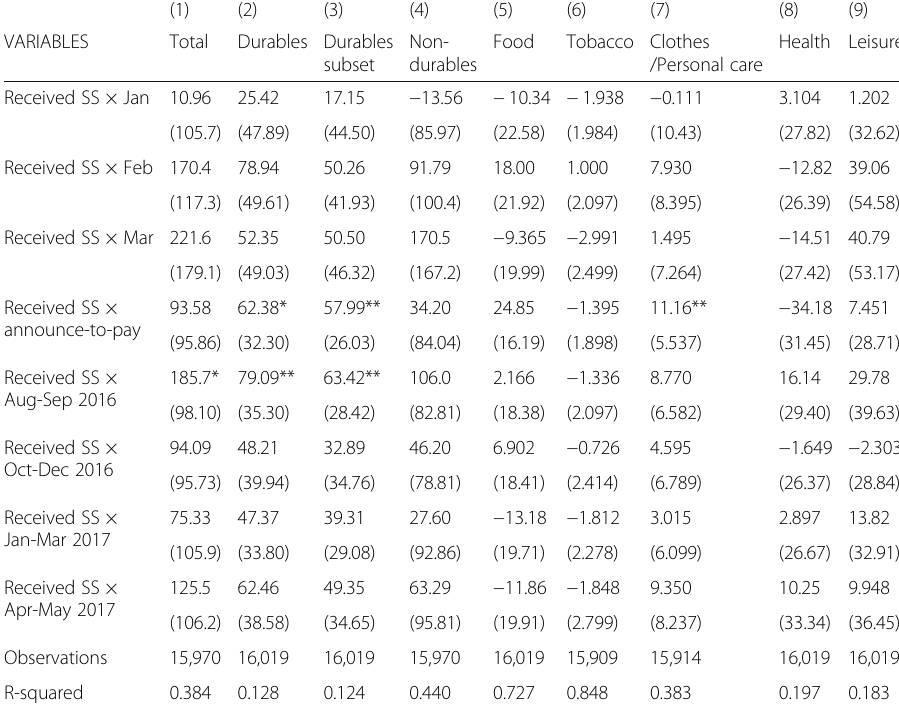
Table 22 Temporal impact of receiving SSS payouts on